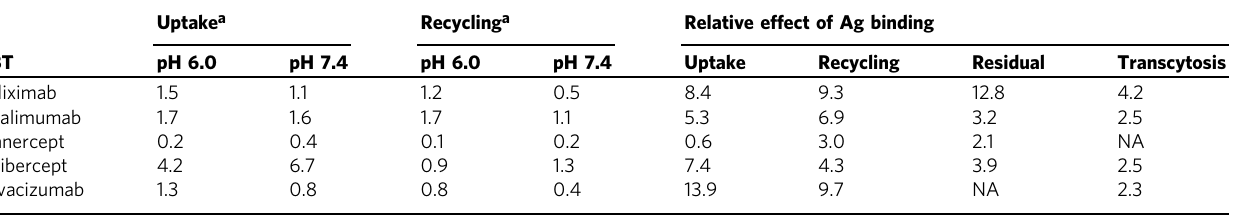
Table 2 Summary of key cellular transport parameters of ABTs in the absence and presence of cognate